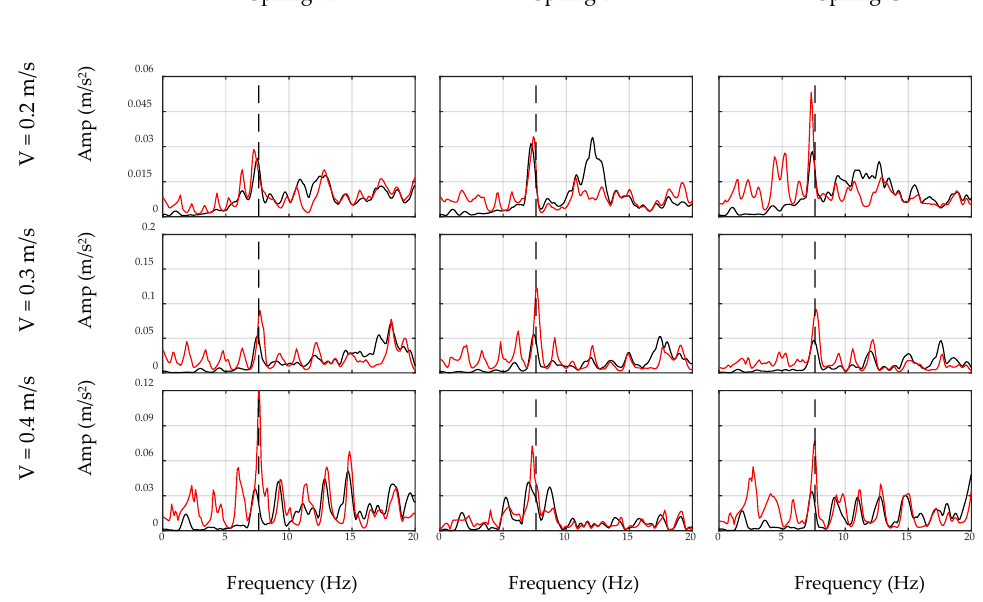
Figure 18. Unfiltered (black) and filtered (red) spectrums of on-bridge data collected by sensor.